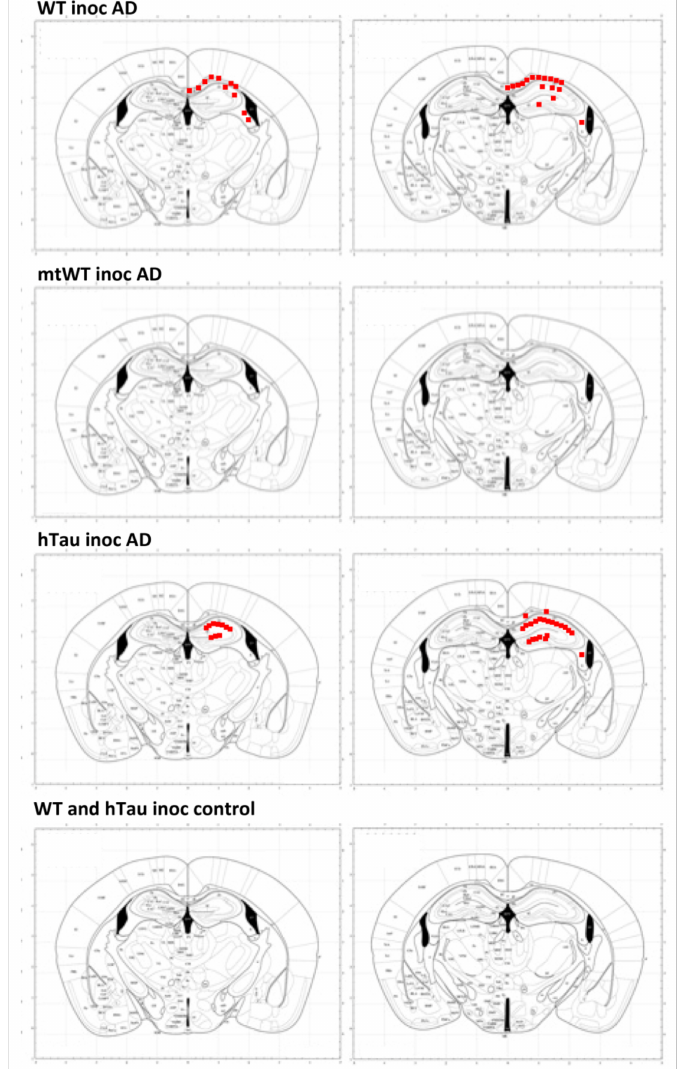
Figure 6. The distribution of abnormal tau deposits in WT, mtWT, and hTau unilaterally inoculated in the hippocampus with the same inocula of sarkosyl-insoluble fraction of AD and WT, and hTau inoculated with sarkosyl-insoluble fractions from one control brain. Mice were inoculated at the age of six months and killed at the age of nine months. Red points are tau deposits representative of deposits depicted in Figures 4 and 5. Tau deposits are not detected in mtWT inoculated with AD sarkosyl-insoluble fractions. In contrast, Tau deposits are found in WT and hTau inoculated with AD sarkosyl-insoluble fractions. Tau deposits in CA1 region and dentate gyrus are more abundant in inoculated hTau mice when compared with WT mice. Tau deposits in the stratum radiatum and stratum oriens are also more abundant in hTau than in WT mice. In contrast, tau deposits in the corpus callosum and fimbria (involving glial cells) are more copious in inoculated WT mice. No abnormal tau deposits are detected in WT and hTau mice inoculated with sarkosyl-insoluble fractions from a control case. The maps were obtained from the Atlas of Paxinos and Franklin [29] and represent two different coronal levels to facilitate the extent of tau deposits considering the three axes; sections of the left column are more anterior than the sections of the right